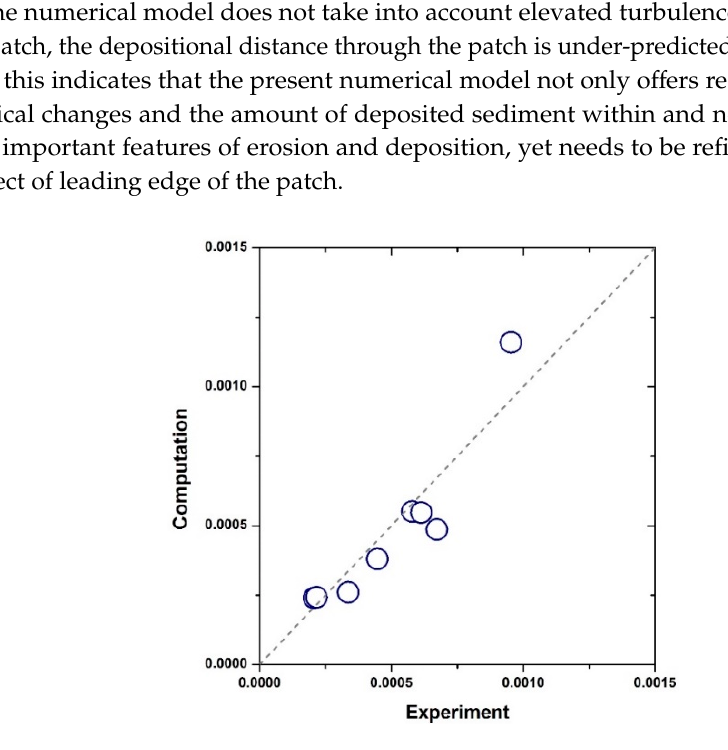
Figure 10. Comparison between experiment and computation of sediment deposition within and around the patch.